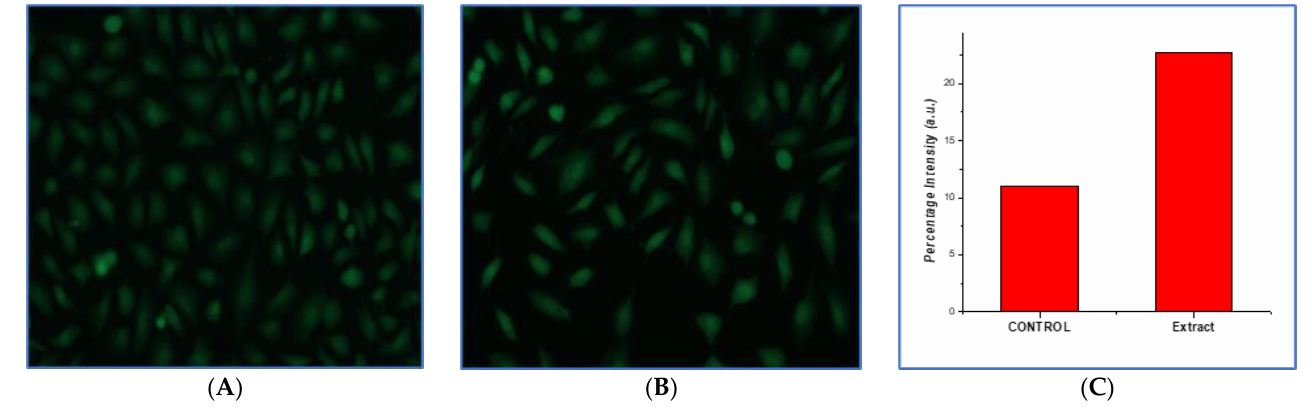
Figure 8. Images depict DCFDA-stained HepG2 cells after 48 h at 20X magnification under a phase-contrast microscope. ( A ) DCFDA experimental control; ( B ) okra extract-treated HepG2 cells; ( C ) fluorescence intensity graphs.